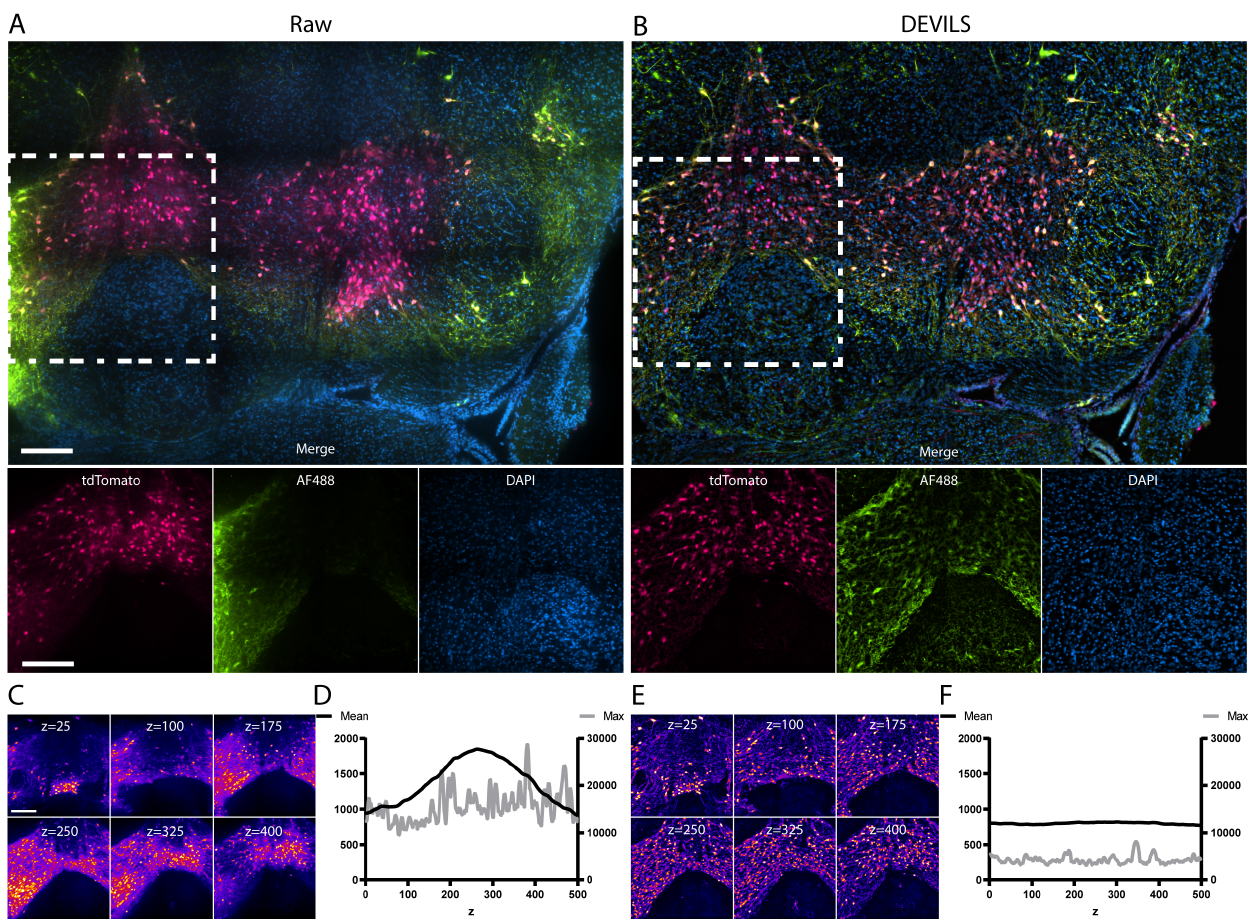
Figure 4. DEVILS applied to a multichannel image. A part of a cleared mouse midbrain was imaged using light-sheet fluorescence microscopy (LSFM). ( A ) Raw and merged display of the three individual channels of a single optical slice. The DAPI nuclear counterstain is false coloured in azure, the α-TH staining is shown in chartreuse (AF488) and the dopaminergic neurons in bright pink (tdTomato). The image is assembled from 24 individual tile images. The dashed square indicates a region used for cropping. Crops for each of the individual channels are shown below the main panel. Scale bars: 250 µm. ( B ) Image A after DEVILS processing ( p = 25). ( C ) Cropped region from A showing the dopaminergic neurons at different Z-positions in the image stack, using the “Fire” look-up table (LUT) and auto contrast adjustment set to 0.35 on slice 280. Scale bar: 250 µm. ( D ) Mean (black) and maximum (Max, grey) intensities (left and right Y-axes, resp.) of the acquisition channel as shown in panel C per Z-plane (X-axis). ( E ) Cropped region from B showing the dopaminergic neurons at different Z-positions in the image stack, using the Fire LUT and auto contrast adjustment set to 0.35. ( F ) Mean (black) and maximum (Max, grey) intensities (left and right Y-axes, resp.) of the acquisition channel as shown in panel E per Z-plane